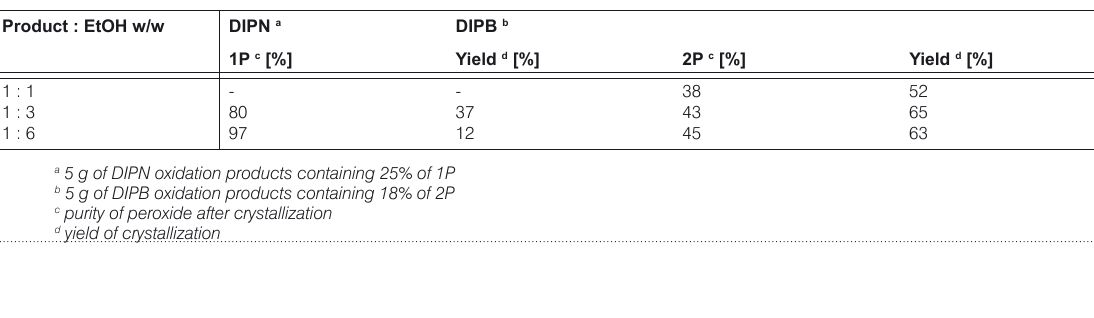
Table 2. Isolation of peroxides from oxidation products by crystallization with